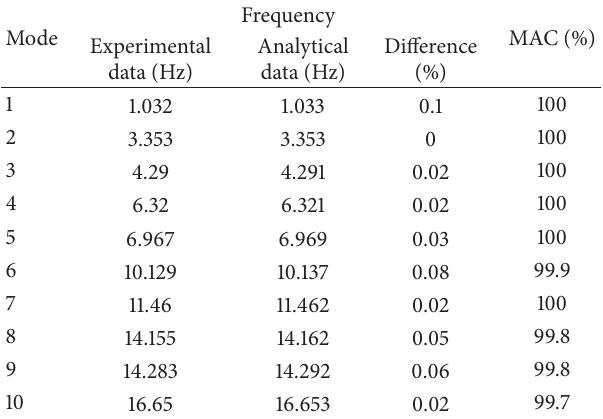
Table 4: Frequencies and mode shapes using the proposed sub- structure